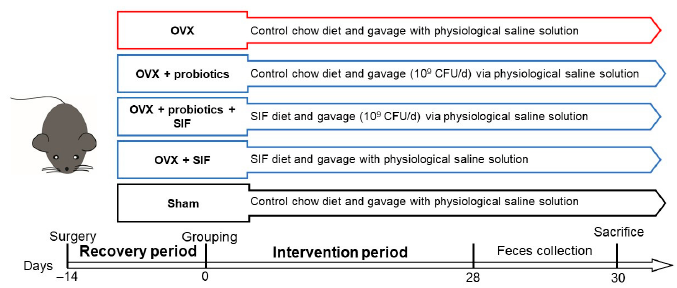
Figure 1. Animal trial design. OVX: Ovariectomy; Sham: Sham-operation. Table 1. Composition of diet in the animal experiment. Control chow diet: phytoestrogen-purified, soy protein free AIN-93M diet [20]; SIF diet: AIN-93M diet containing 0.1% soy isoflavone